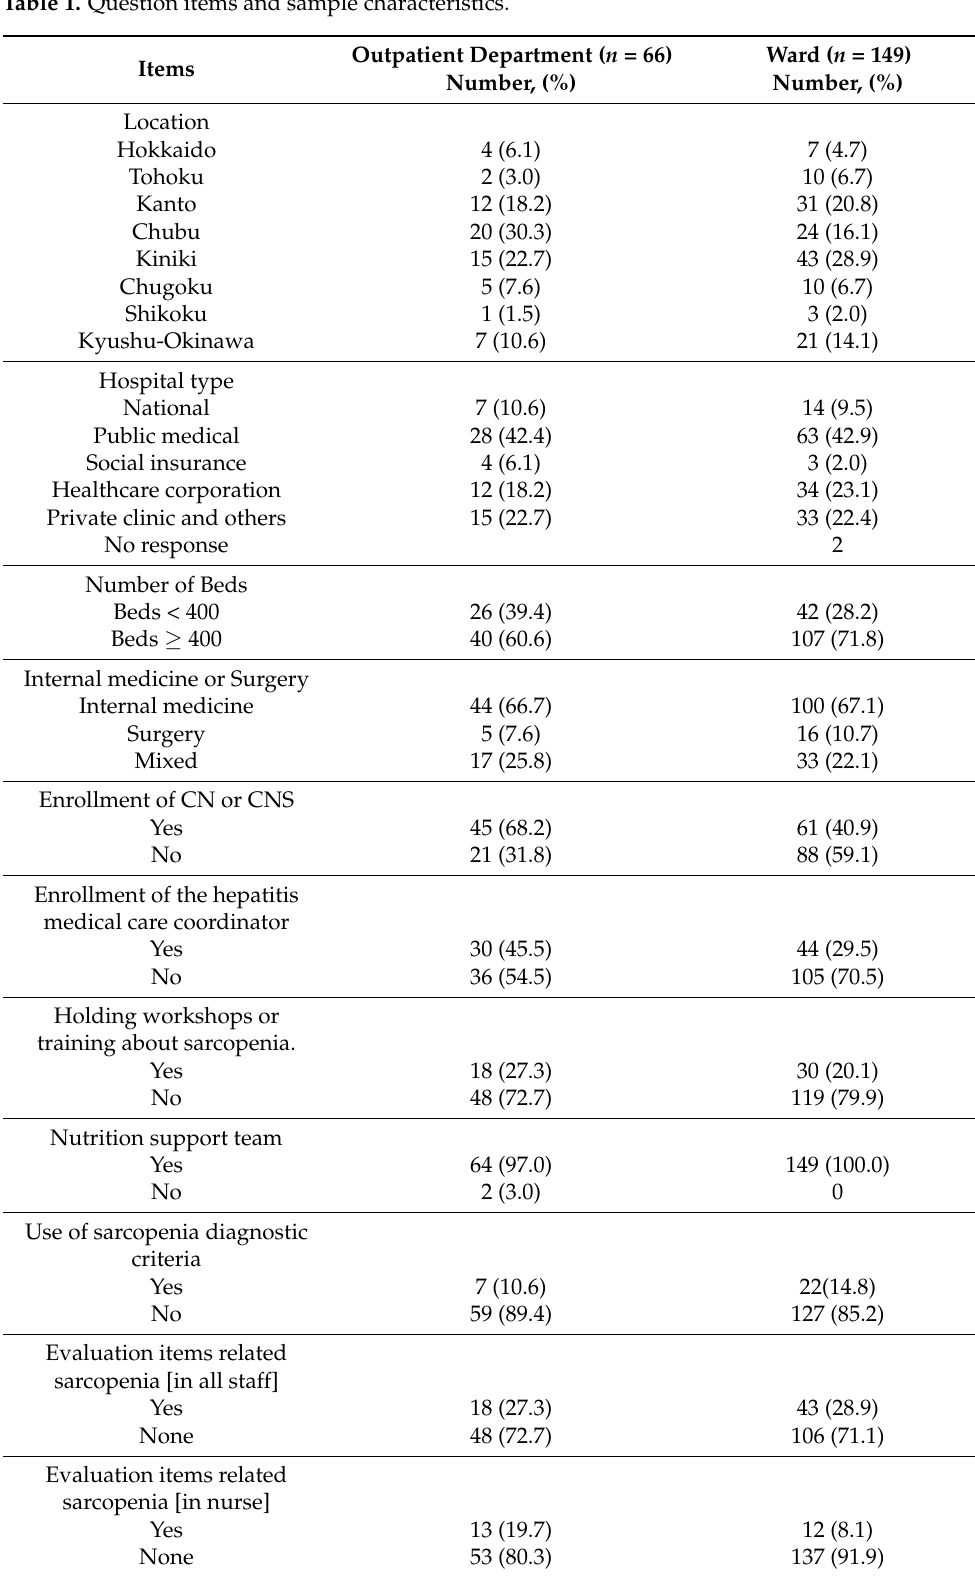
Table 1. Question items and sample